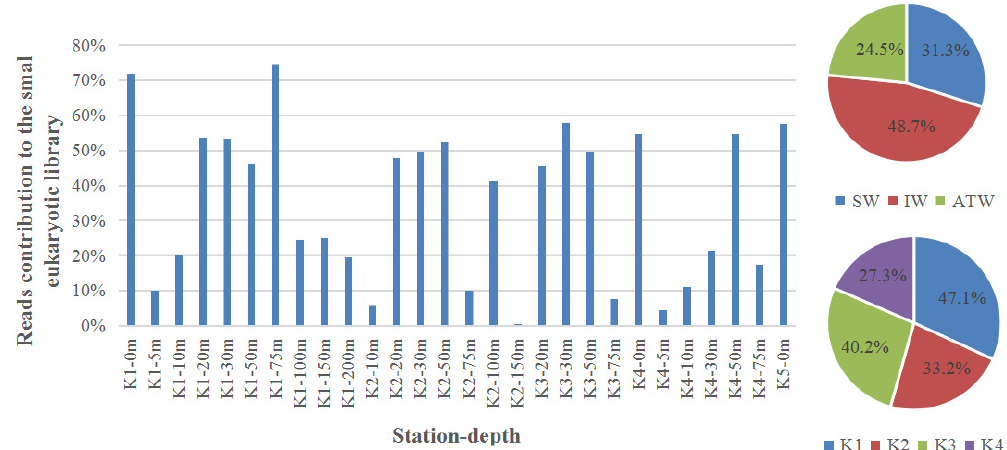
Figure 4. Reads of contributions to the small eukaryotic library of P. malhamensis at different sites in the Kongsfjorden: SW: Surface Water, IW: Intermediate Water, and TAW: Transformed Atlantic Water. K1–K4 stands for four sampling stations from outer to inner fjord.: The upper pie presents the average propertions of P. malhamensis at different water masses; and the lower pie presents the average propertions of P. malhamensis at different